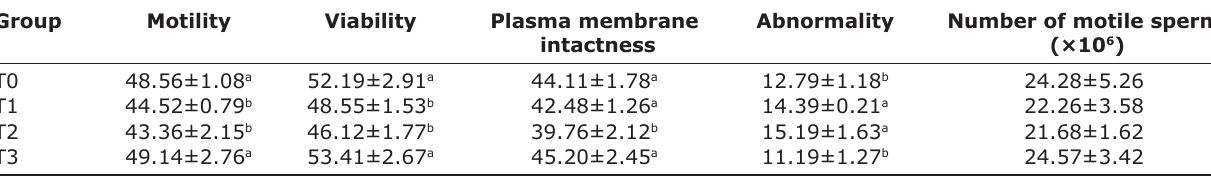
Table‑3: Quality and the number of motile post-thawed sperm cells per straw of the sexed Simmental bull semen (n=6). Group